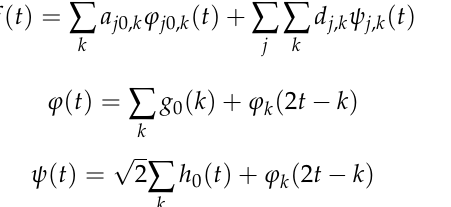
Figure 5. Feature distribution of the MRA. ( a ) Normal motor, ( b ) bearing fault, ( c ) interturn short circuit, ( d ) broken rotor bar. Table 1. Feature extraction of the MRA. a5